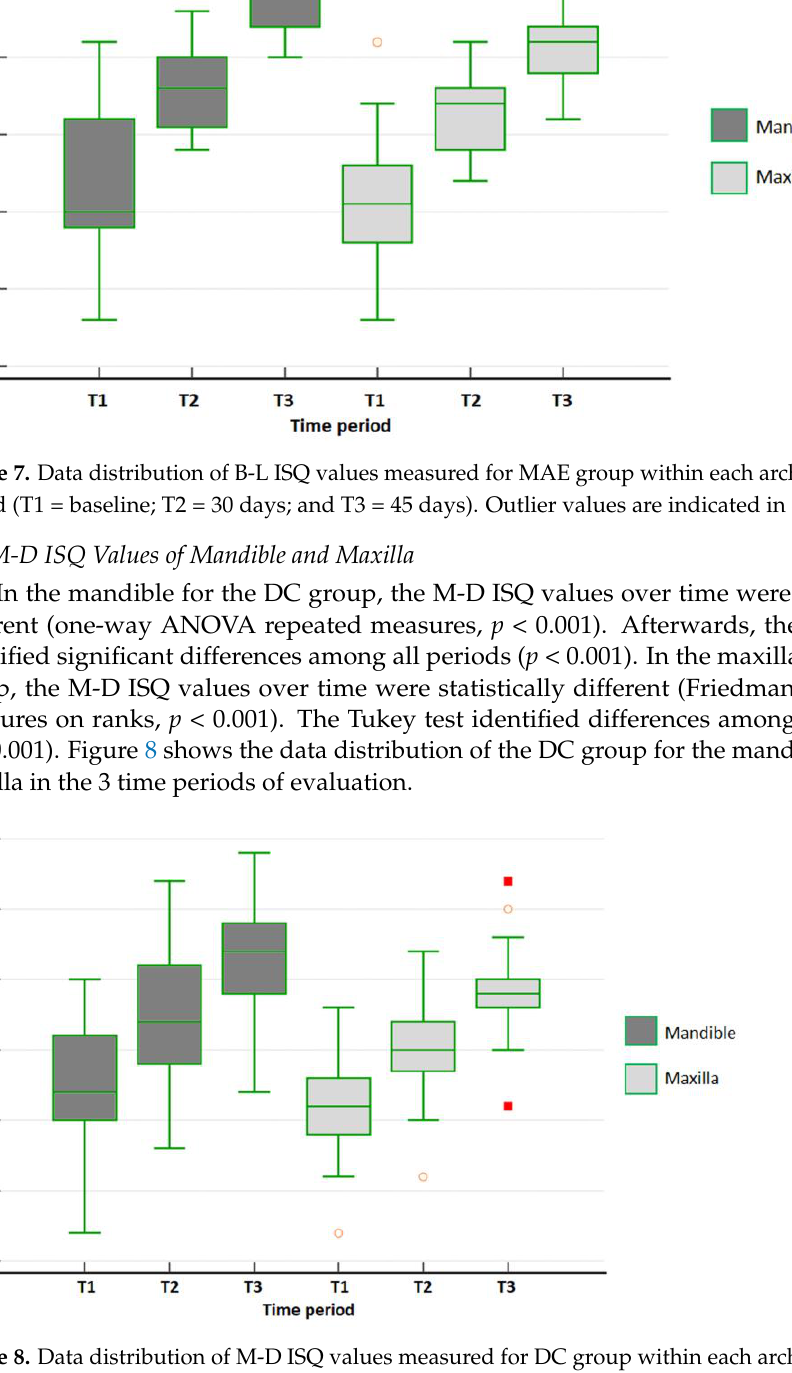
period (T1 = baseline; T2 = 30 days; and T3 = 45 days). Outlier values are indicated in orange.